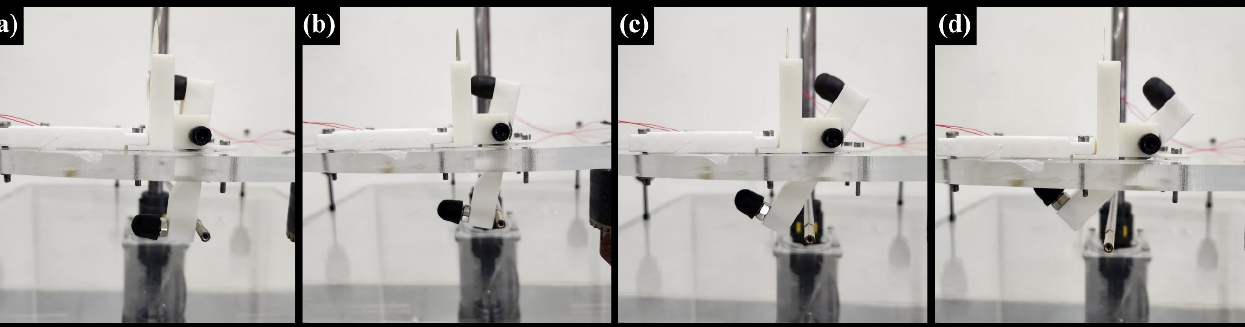
Figure 5. Side views of dynamic hammer-impact-driven power generator when the impeller rotates at speeds of ( a ) 50, ( b ) 100, ( c ) 150, and ( d ) 200 RPM.